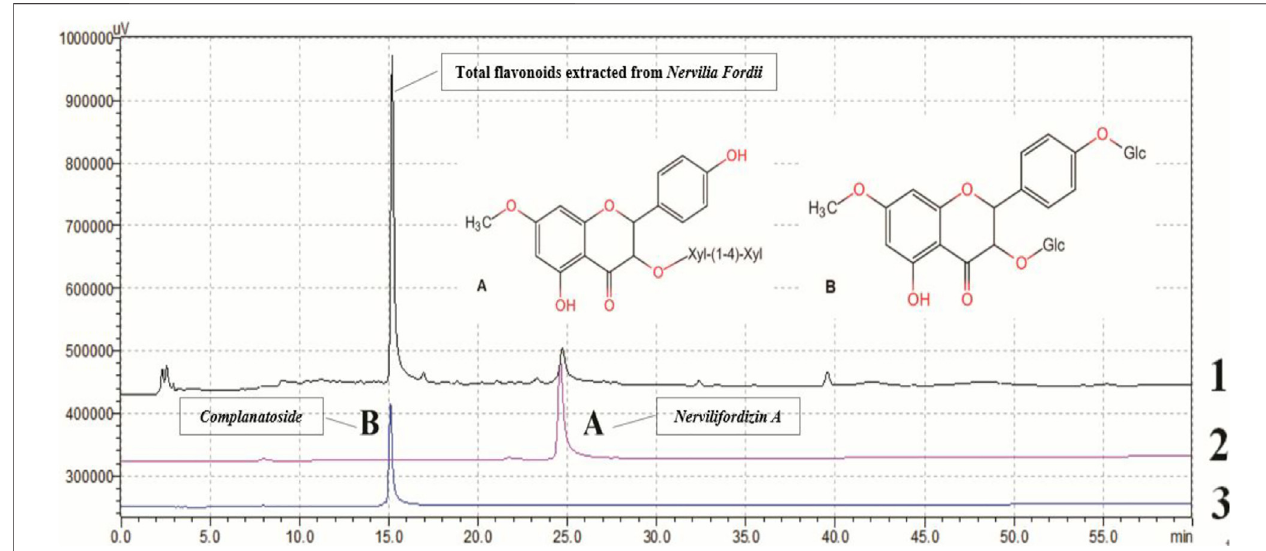
FIGURE 1 | Chemical pro fi le of TFENF analyzed using HPLC. 1. Total fl avonoids extracted from Nervilia fordii ; 2 (A) Nervilifordizin A ; 3 (B) Complanatoside .